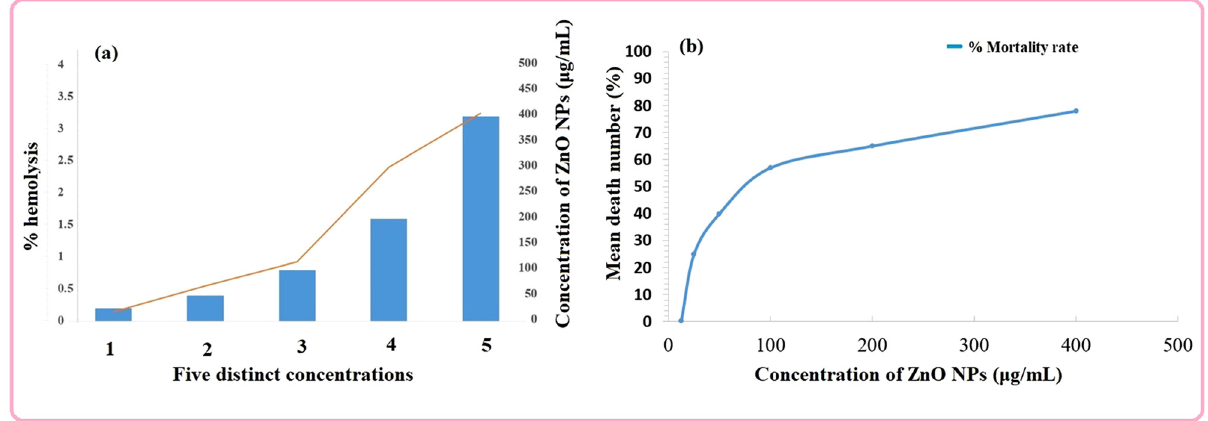
Figure 6: ( a ) % Hemolysis behavior of biogenic NPs at various concentrations and ( b ) correlation between NPs concentration and brine shrimp % mean mortality for cytotoxicity